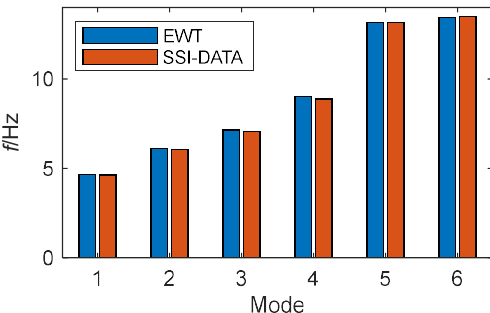
Figure 19. Comparison of modal frequencies for DHF identified by EWT and SSI-DATA.